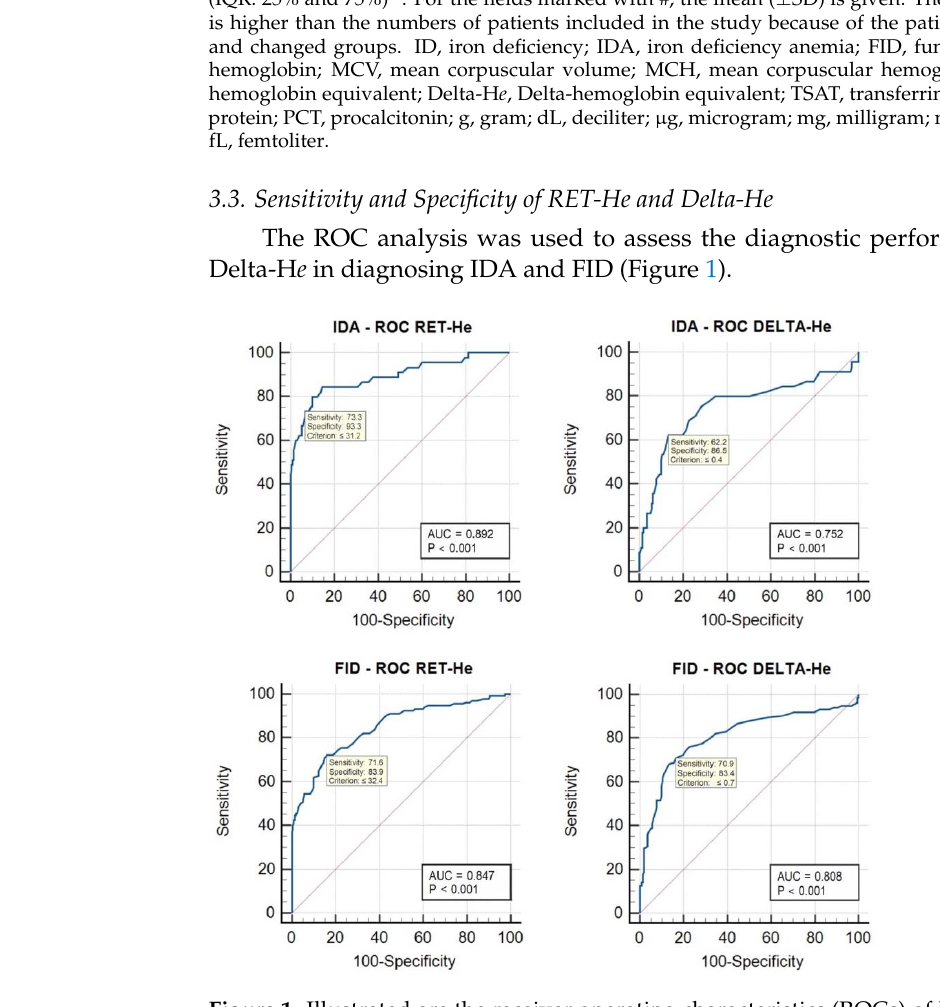
Figure 1. Illustrated are the receiver operating characteristics (ROCs) of RET-H e and Delta-H e for the group of patients with IDA and FID. The calculated optimal cutoff points (criterion) with their sensitivity and specificity, the area under the curve (AUC), and the level of significance (P) are also